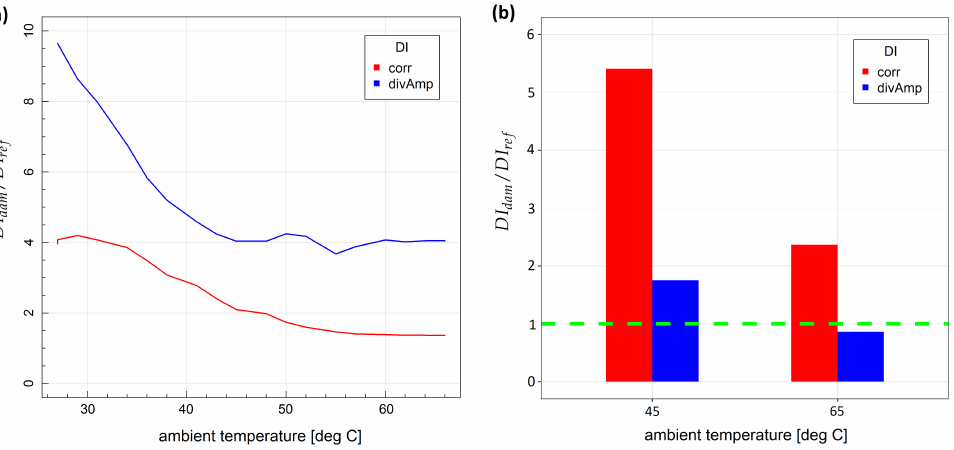
Figure 9. Comparison of damage indices obtained for sensing paths influenced by damage and distant from it under temperature variation: ( a ) specimen no. 1; ( b ) specimen no.